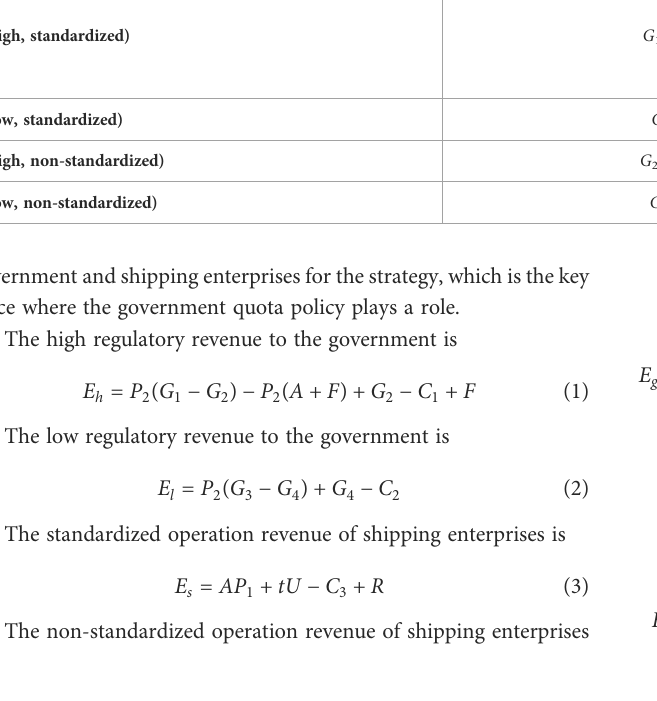
TABLE 4 Revenue matrix of the third stage.